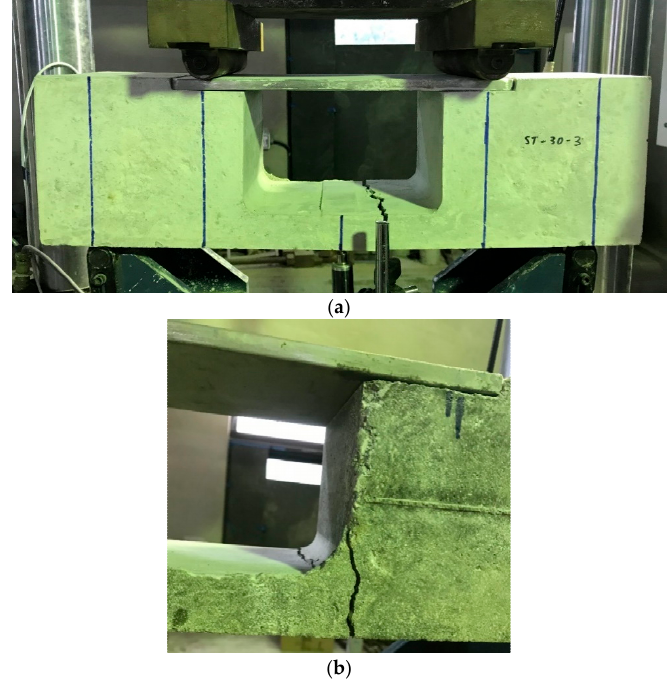
Figure 23. Failure mode of strut-and-tie method: ( a ) typical failure and ( b ) unexpected failure. Table 6. Summary of test results.